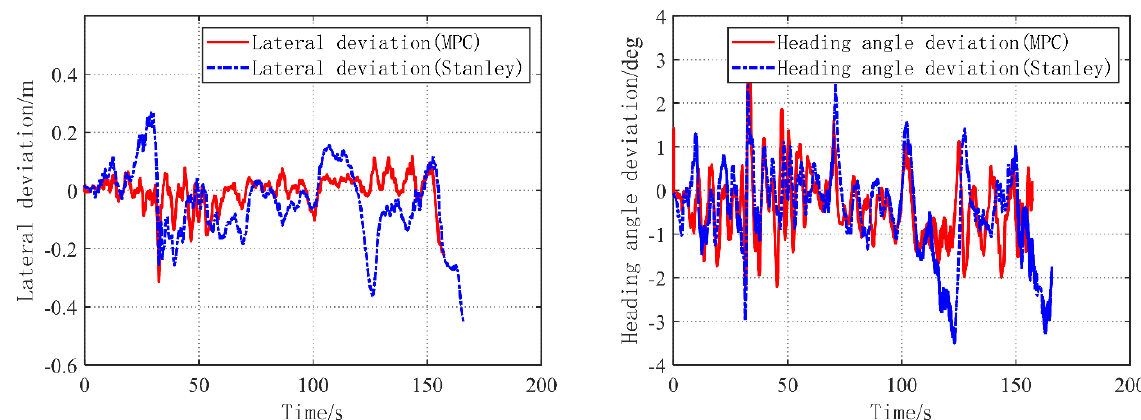
Figure 15. Lateral error and heading angle deviation of MPC control and Stanley control. Under the S-shaped reference path with the target speed of 20 km/h, the vehicle is tested with the MPC controller and the Stanley controller, respectively. Except for the lateral controller, other configurations are the same. The experimental results are shown in Figures 16–18.